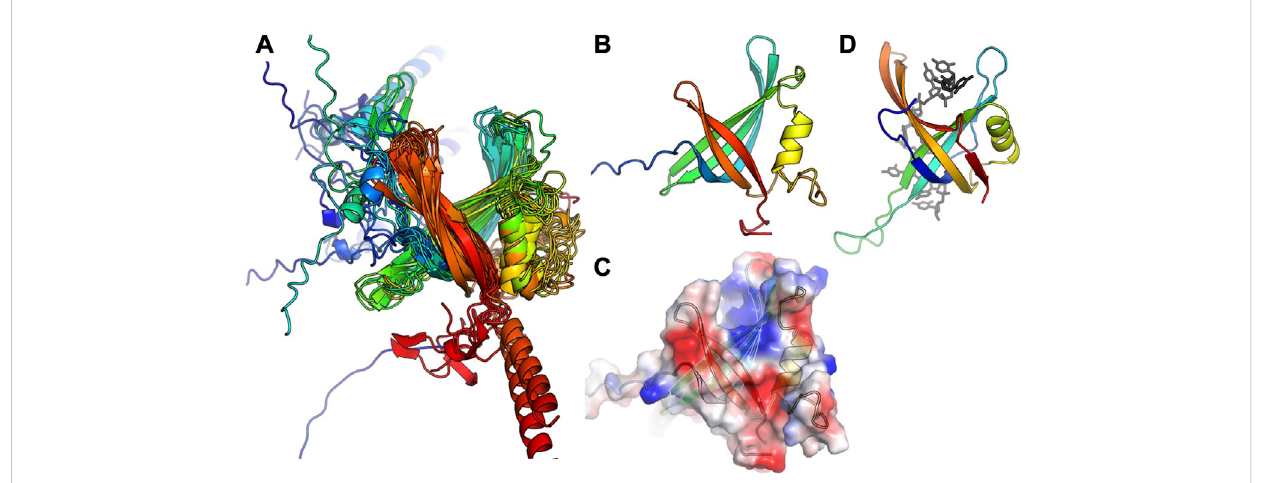
FIGURE 3 The predicted SSB subunits have an OB fold. (A) Superposition of all 16 predicted structures, colored blue to red from N to C. (B) The predicted structure of MP from S. aureus type V SCCmec. (C) Semi-transparent surface of the model in (B) colored according to vacuum electrostatics (blue is positive; red is negative) (D) one subunit from E. coli SSB, with ssDNA bound, for comparison (PDB ID 1eyg: Raghunathan et al., 2000).